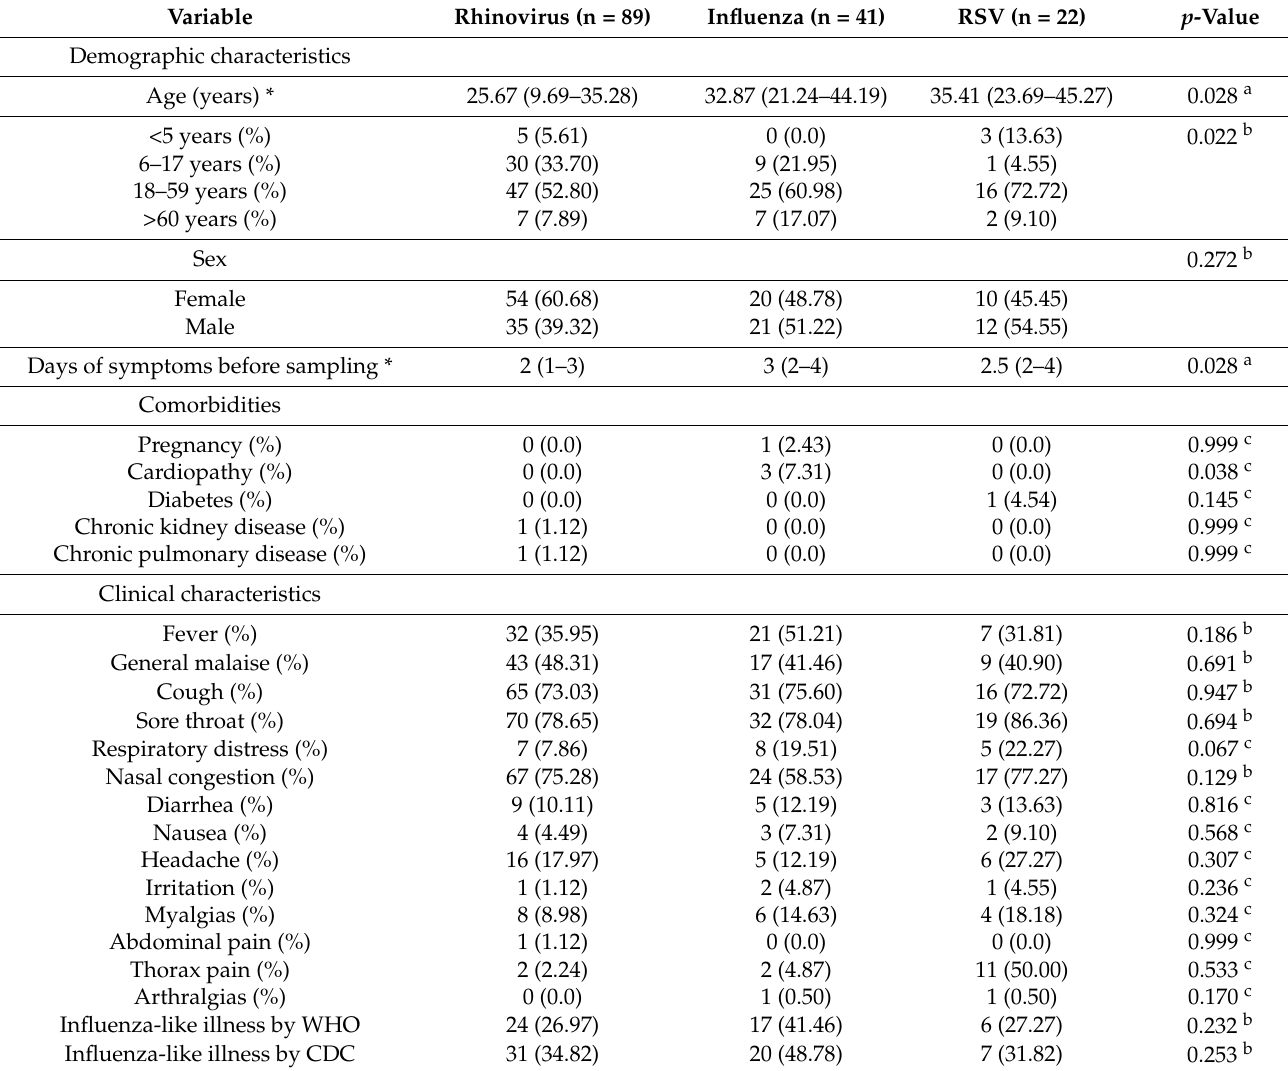
Table 2. Variables in relation to principal pathogens. This table compares the demographic and clinical characteristics of the study population with the main respiratory viruses detected.